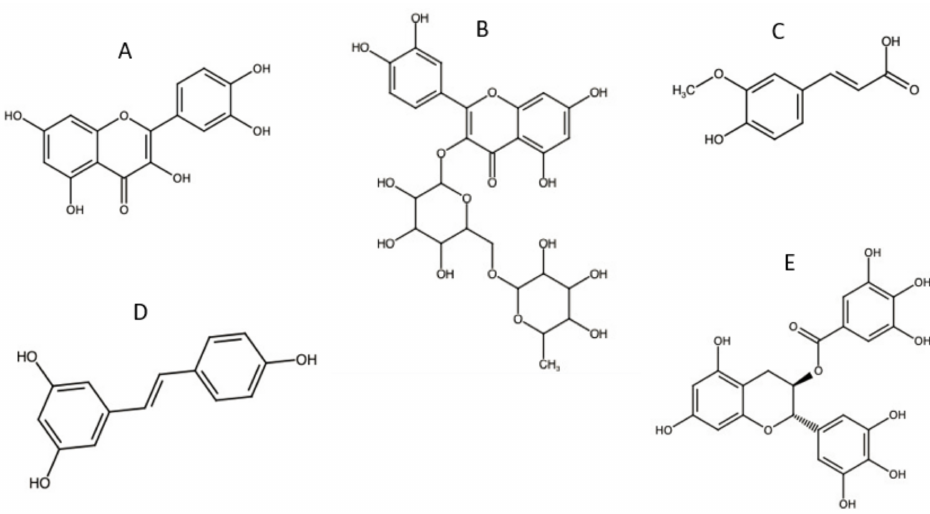
Figure 4. Chemical structures of commonly natural antioxidants complexed with cyclodextrins (CDs): ( A ) quercetin (QCT), ( B ) rutin, ( C ) ferulic acid, ( D ) trans- resveratrol, and ( E ) epigallocatechin